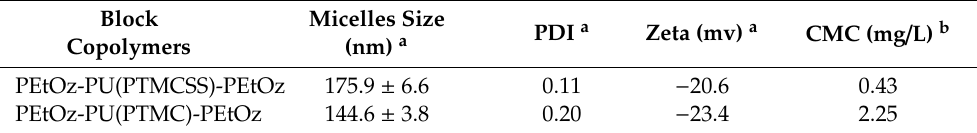
Table 1. Characteristics of PEtOz-PU(PTMCSS)-PEtOz and PEtOz-PU(PTMC)-PEtOz micelles. Block